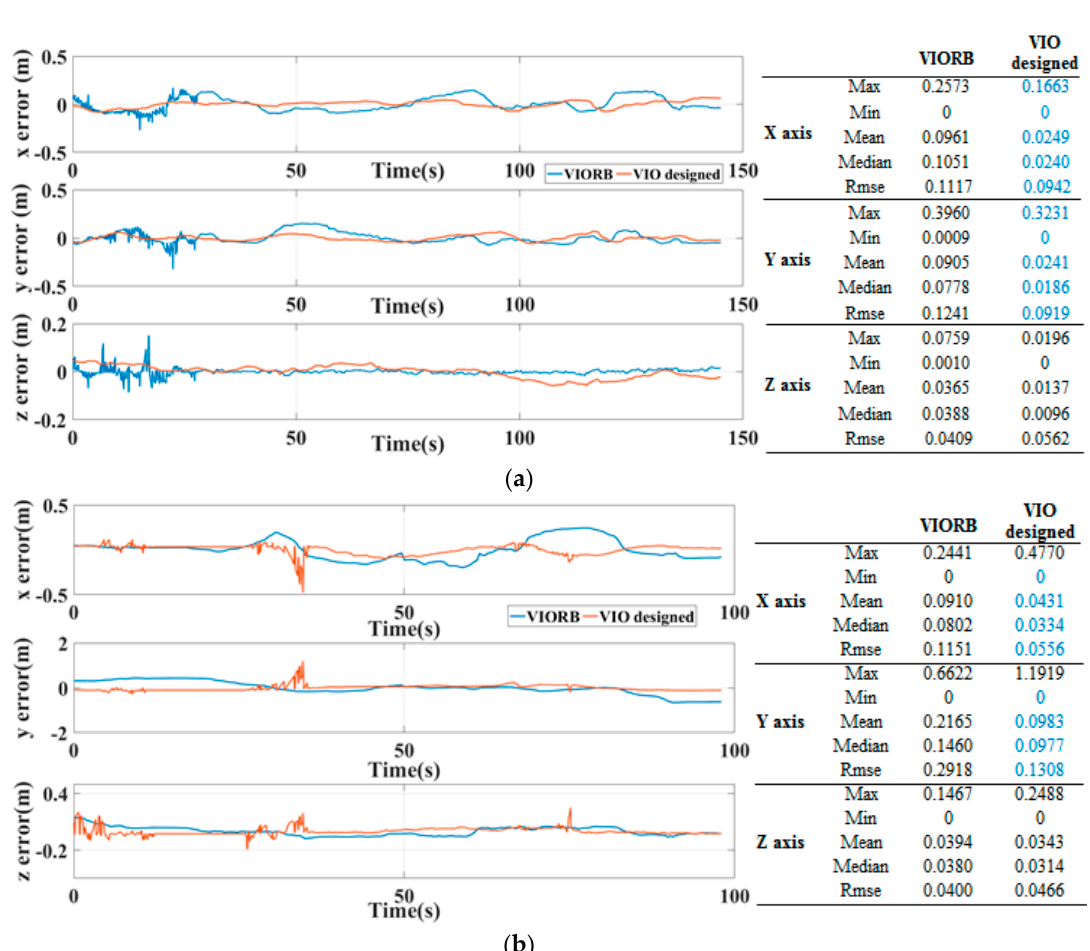
Figure 8. VIO planar trajectory comparisons, ( a ) V1_01_easy sequence; ( b ) MH_04_difficult sequence.